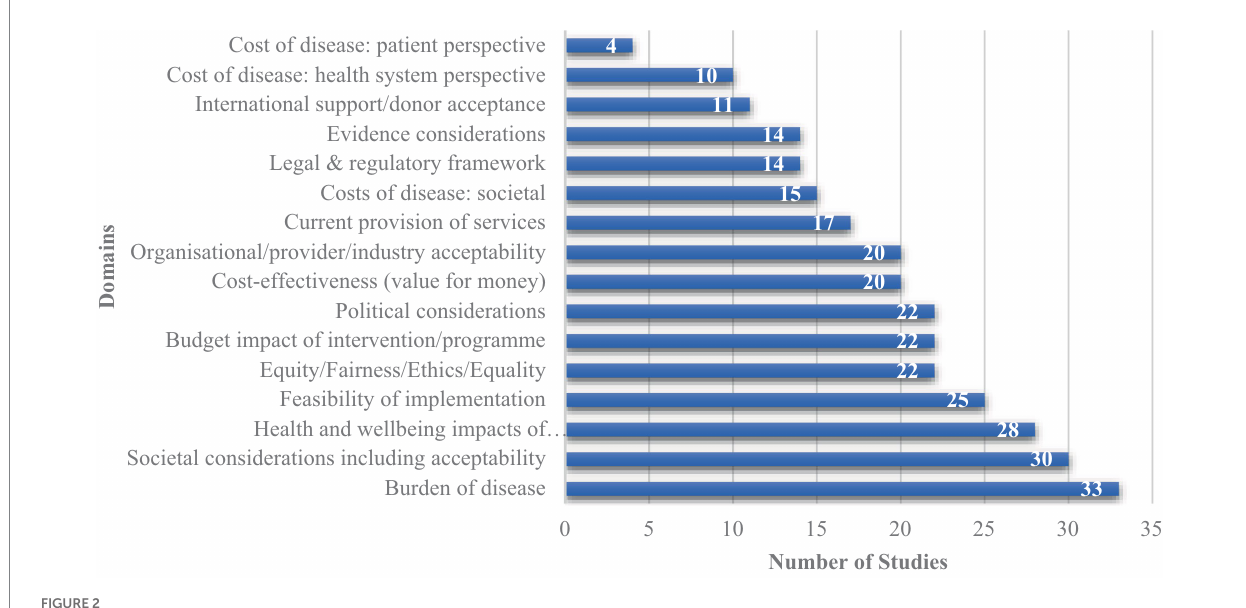
FIGURE 2 Frequency of prioritisation domains cited in included